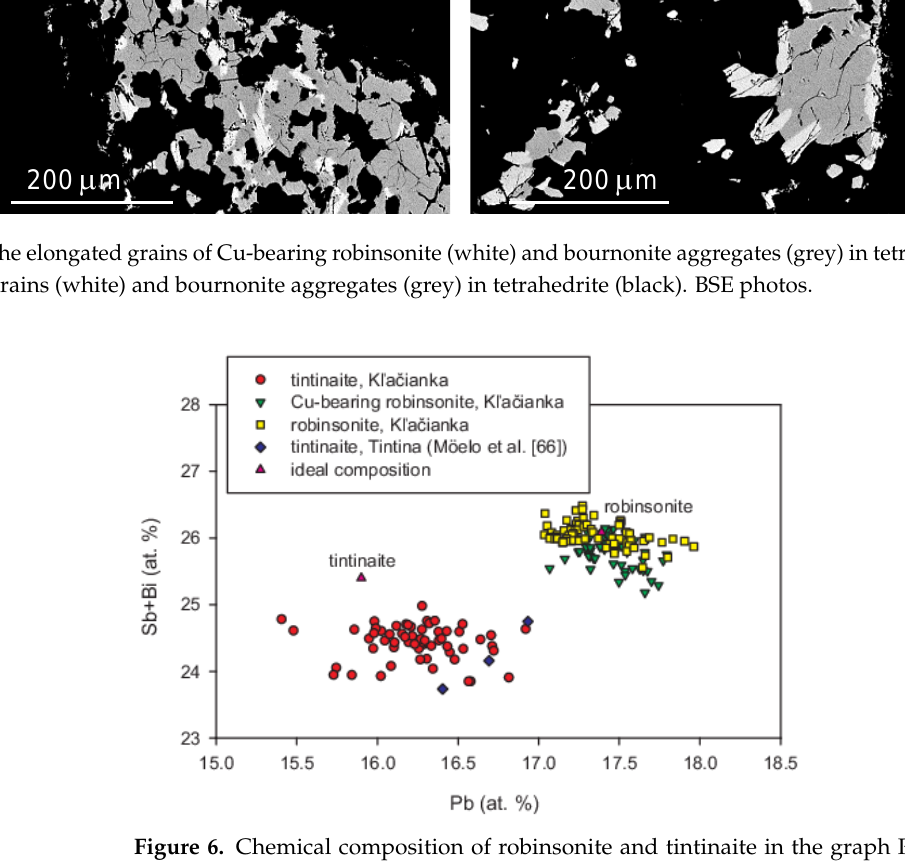
Figure 6. Chemical composition of robinsonite and tintinaite in the graph Pb vs. Sb + Bi ( at.%); theoretical composition: robinsonite Pb 4 Sb 6 S 13 ; tintinaite Pb 10 Cu 2 (Sb,Bi) 16 S 35 .